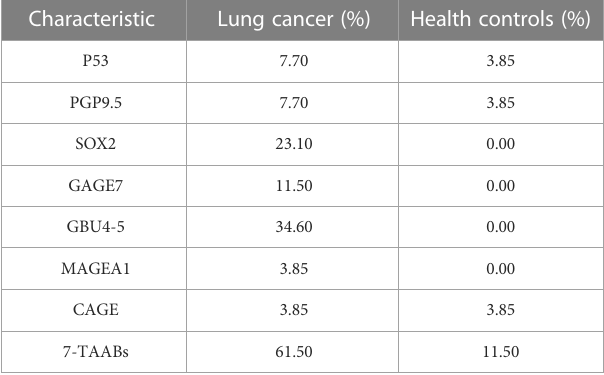
TABLE 3 The positive rates of TAABs in lung cancer patients and their age-, gender- and -smoking-history-matched healthy controls. Characteristic Lung cancer